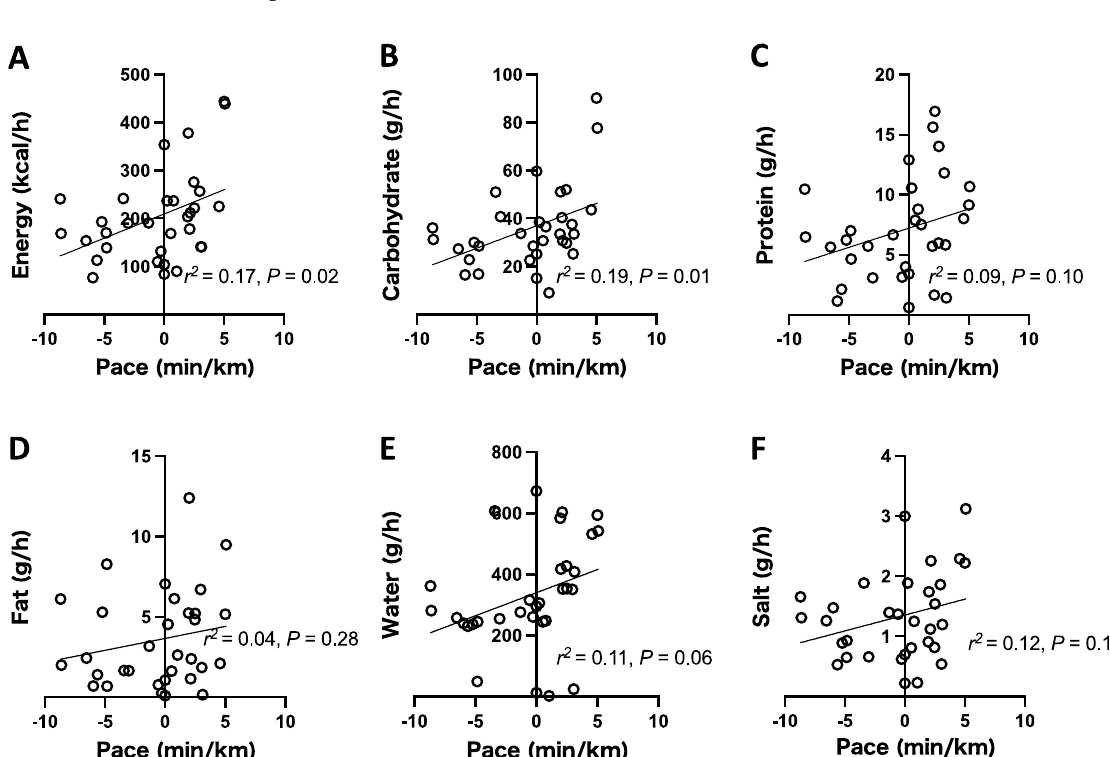
Figure 4. Scatter plots showing the relationships between nutrient intake and running pace. The intake of energy ( A ), carbohydrate ( B ), protein ( C ), fat ( D ), water ( E ), and salt ( F ) was calculated according to the nutrition information of the consumed food and fluid products. Each plot indicates one segment.